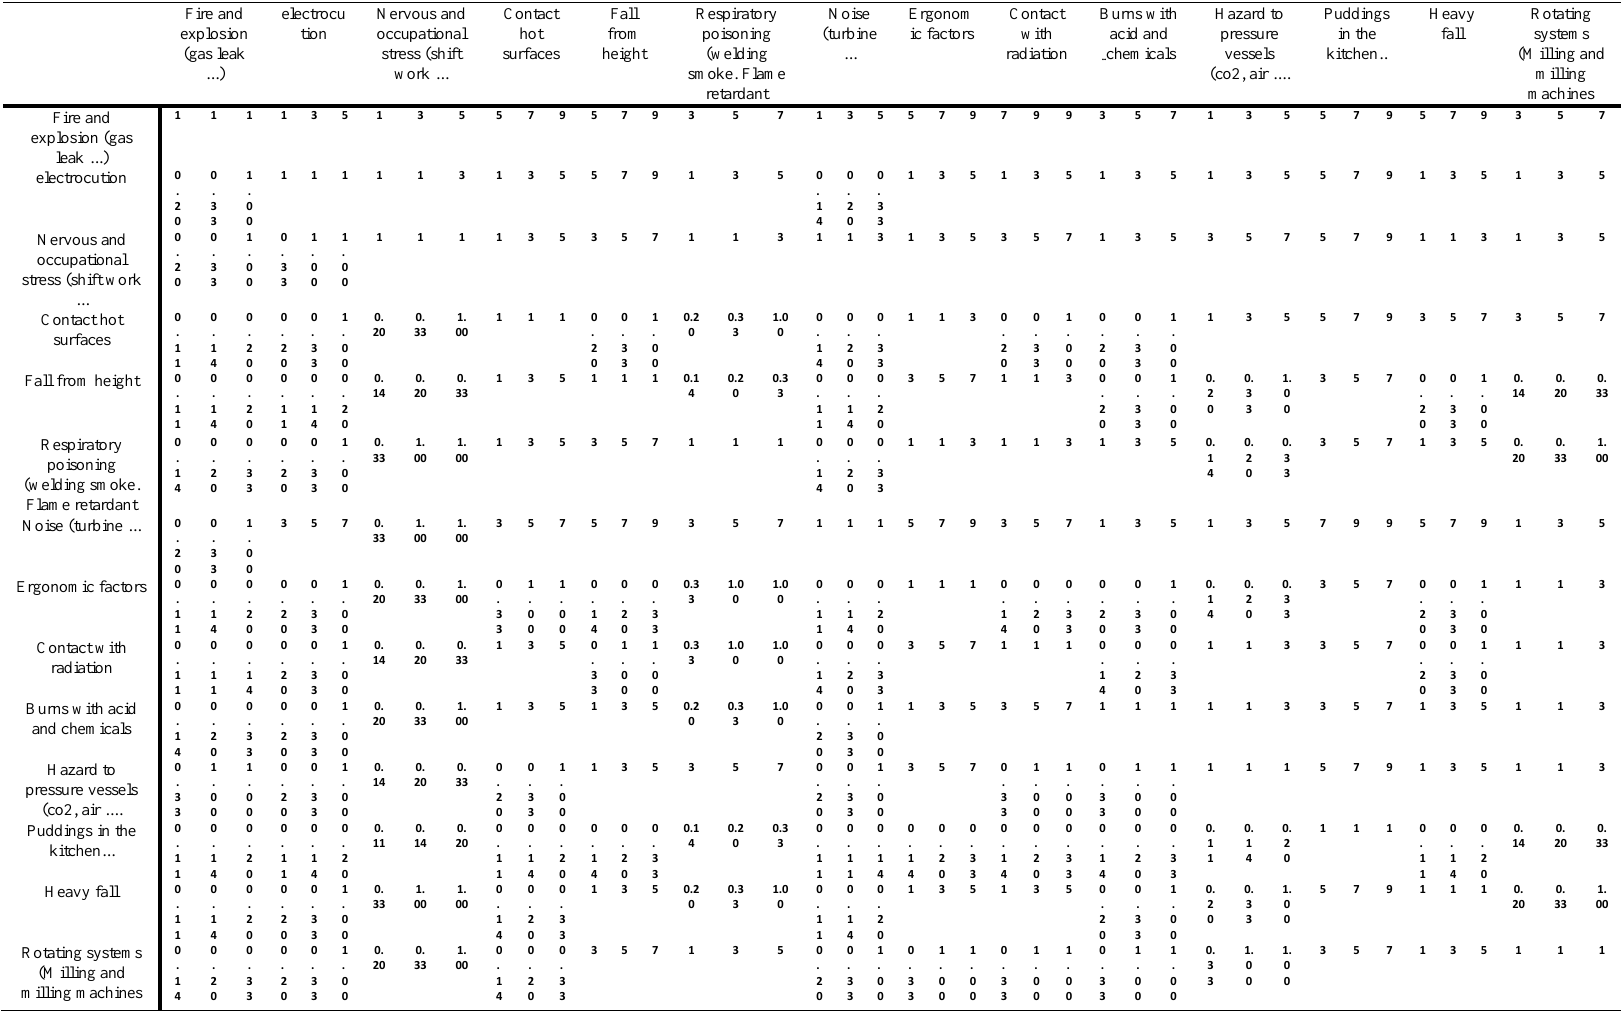
Table 8. Compensation coefficient calculation of health people